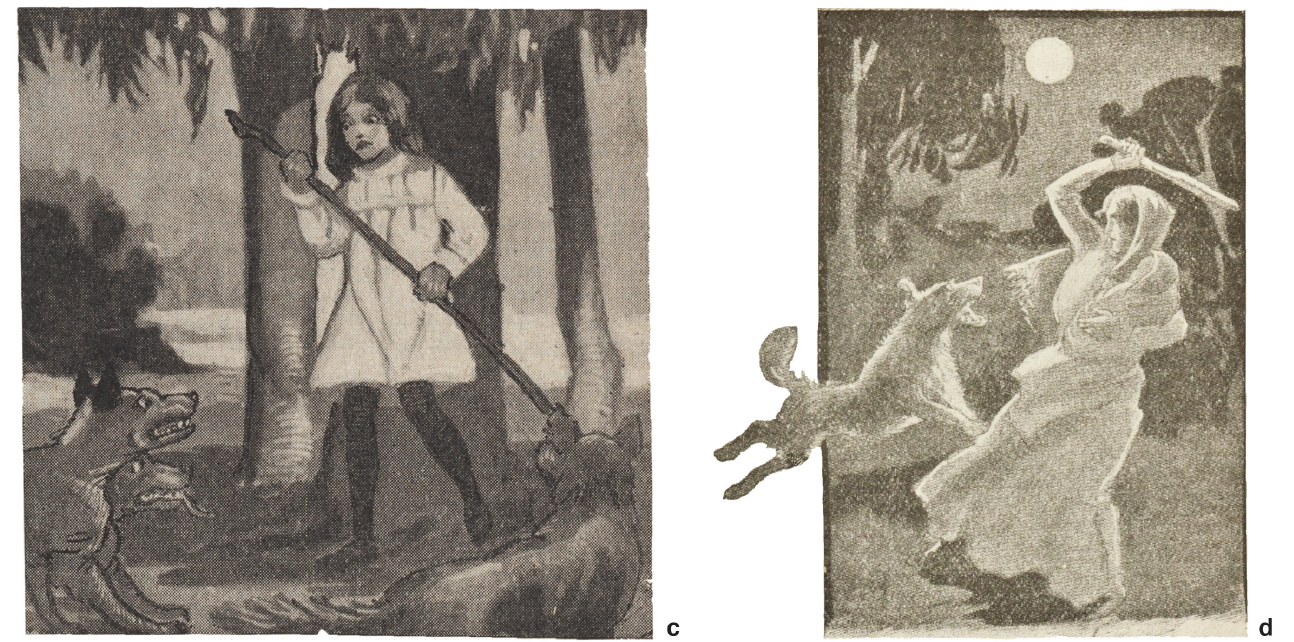
Figure 3. Early depictions of dingoes attacking European settlers. ( a ) Dingoes pursuing a man on horseback. This is a portrayal of an incident that is supposed to have taken place in the Para River region (South Australia) in the mid-19th century [55] ( b ) A pair of dingoes chasing a woman up a tree [56]. Published in 1884 (redrawn from the original using the Adobe Illustrator Live Trace tool [setting: Default]), this is an illustration of an event that is purported to have taken place in 1884 in Queensland [51]; ( c ) dingoes circling a lost child [57]; ( d ) a dingo attacking a woman carrying an infant [58]. The latter two artworks are from fictional stories. Sources: ( a ): ‘The Dingo Or Native Dog’ (Walter Hart, 27 July 1866), State Library Victoria; ( b ): Title: ‘Tree’d by dingoes: a pretty girl on the Dawson River, Queensland, takes refuge from the attentions of native dogs of too much taste’ [56]; ( c , d ): National Library of Australia.